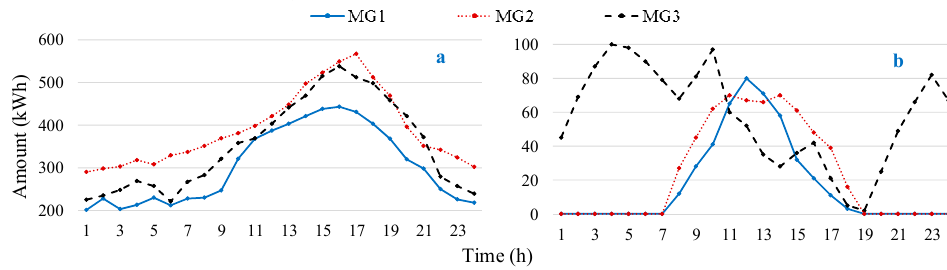
Figure 5. Input parameters of each microgrid: ( a ) Forecasted load values; ( b ) renewable power output.